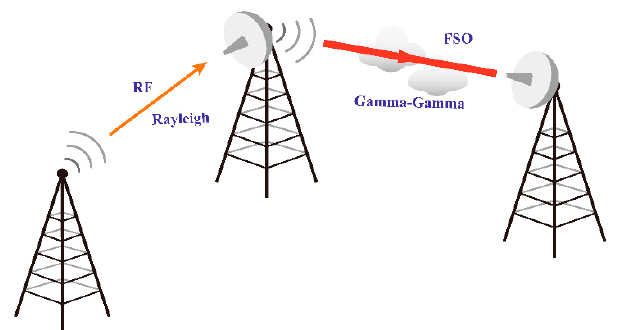
Figure 1. End-to-end mixed radio frequency (RF) and free space optical (FSO) communication system.